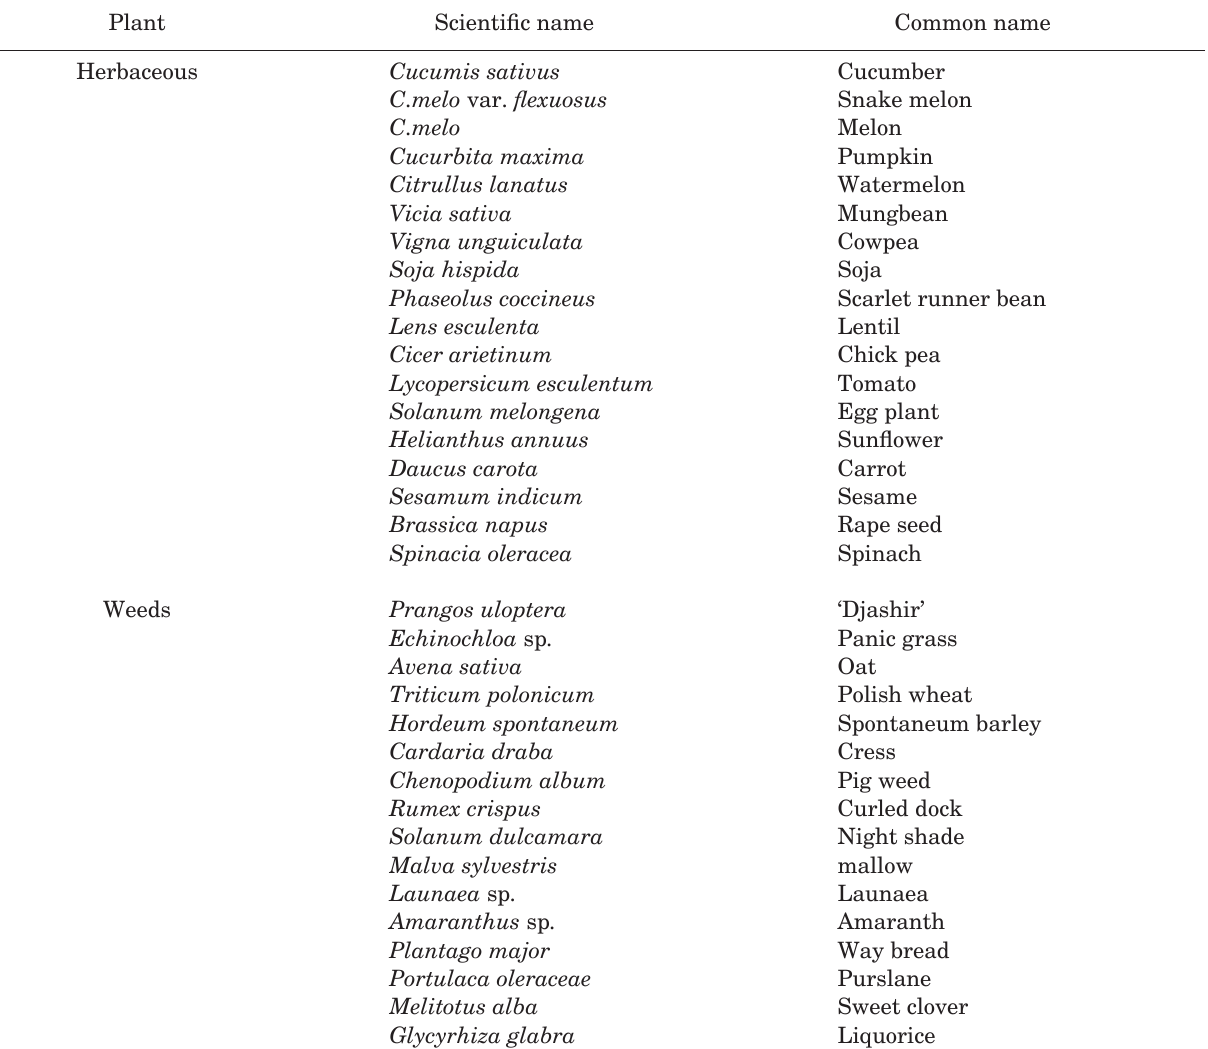
Table 3. Herbaceous plants and weeds inoculated with Phytophthora parsiana under glasshouse conditions.